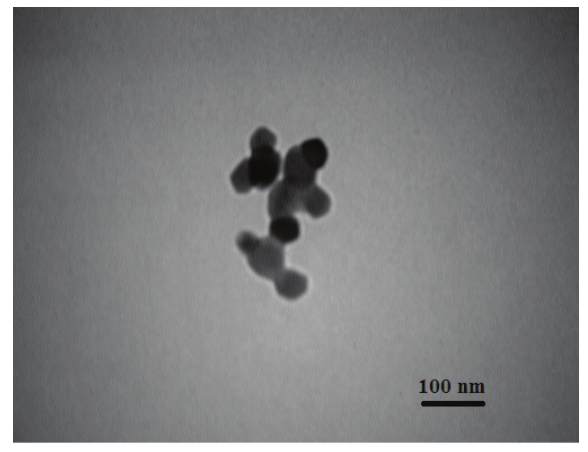
(WO ) nanoparticles synthesized by the 2 4 3